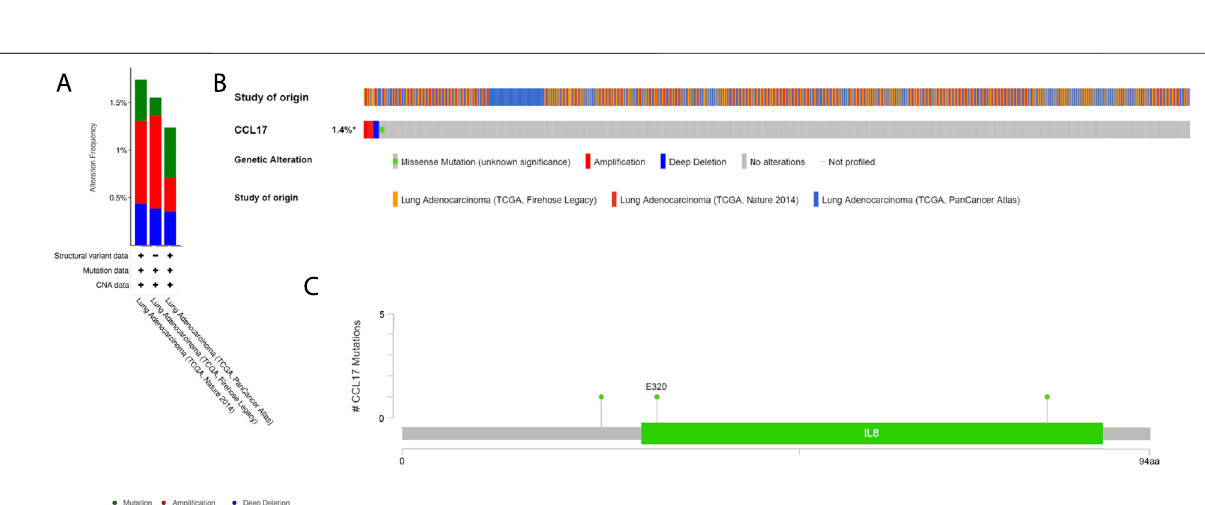
Frontiers in Cell and Developmental Biology |